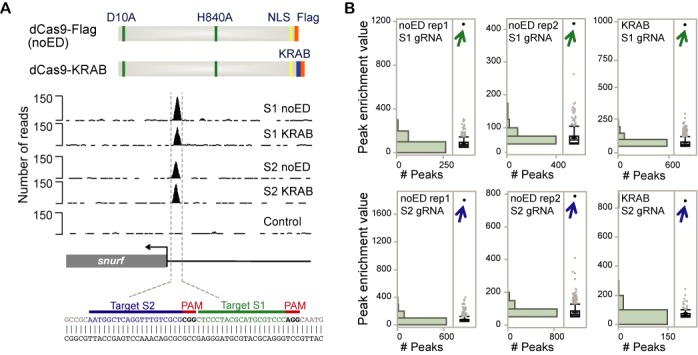
Genome-wide analysis of RNA-guided dCas9 binding in Neuro-2a cells. (A) Diagram of the Flag-tagged Cas9 double mutant (dCas9) used in ChIP-seq assay. dCas9 without an effector domain (dCas9-Flag) or fused to a KRAB repressor domain (dCas9-KRAB) are shown at top. Location of nuclear localization domain (NLS) is indicated in yellow, 3X Falg-tag is shown in orange and KRAB domain is high lighted in blue. ChIP-seq profile of dCas9 binding at the on-target site in the mouse Snurf locus is shown in the middle. Binding is shown for dCas9-Flag without an effector domain (noED) or with the KRAB repressor domain (KRAB). RNA-guided binding via S1 and S2 gRNAs is depicted. A U6 promoter plasmid that did not express functional gRNA was used as a control. Nucleotide sequence targeted by S1 and S2 gRNA is shown at bottom. (B) Distribution of ChIP-seq peak enrichment is shown for two experiments (rep1 and rep2) for dCas9-Flag without an effector domain and for dCas9 fused to the KRAB repressor domain. ChIP-seq enrichment values were obtained using the MACS1.4 peak caller using genomic input DNA as a control. Results are shown for S1 and S2 gRNAs. On-target binding to the Snurf promoter is indicated with an arrow.